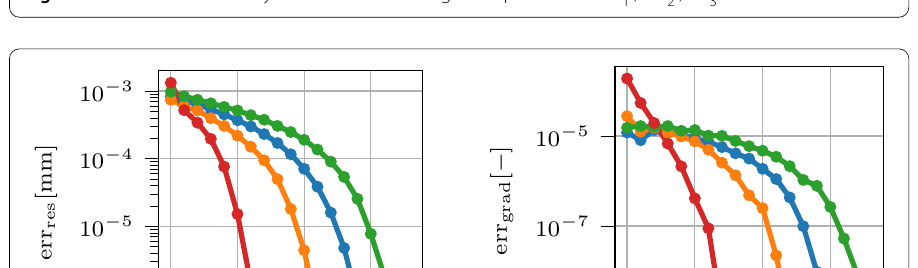
Fig. 22 Result of inverse analysis over iterations for growth parameters a K g